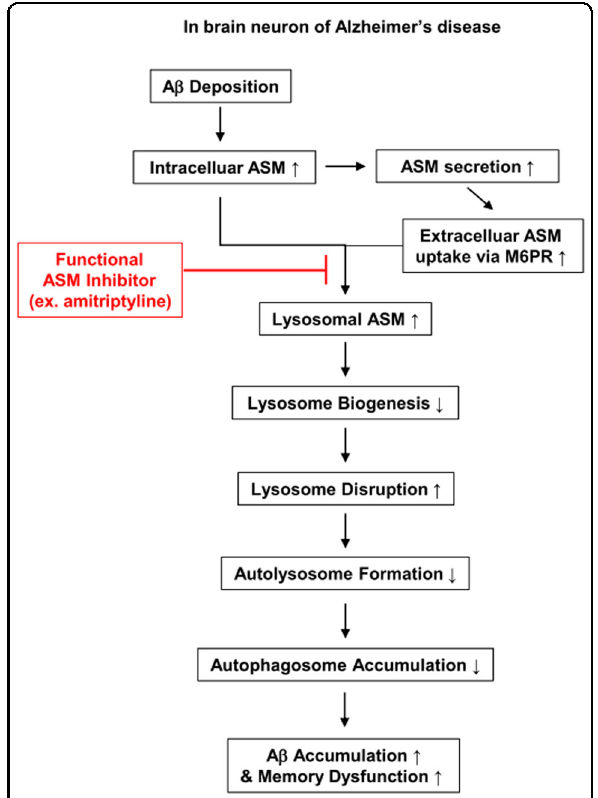
Fig. 2 Schematic summary of ASM-mediated pathophysiology and therapeutic effects of ASM inhibition in AD. In AD, ASM is increased in neurons by environmental or cellular stress. Intracellular and secreted ASM can be taken up into the lysosome via M6PR. Excessively increased lysosomal ASM affects lysosomal disruption, and intracellular ASM decreases lysosome biogenesis. This lysosomal disruption by ASM inhibits autophagic protein degradation and further leads to the accumulation of autophagosomes and abnormal proteins, such as A β and cytotoxic proteins. Eventually, autophagic fl ux decreases and induces A β deposition and memory impairment in AD. ASM inhibition by functional inhibitors such as amitriptyline blocks AD progression by ameliorating the autophagic